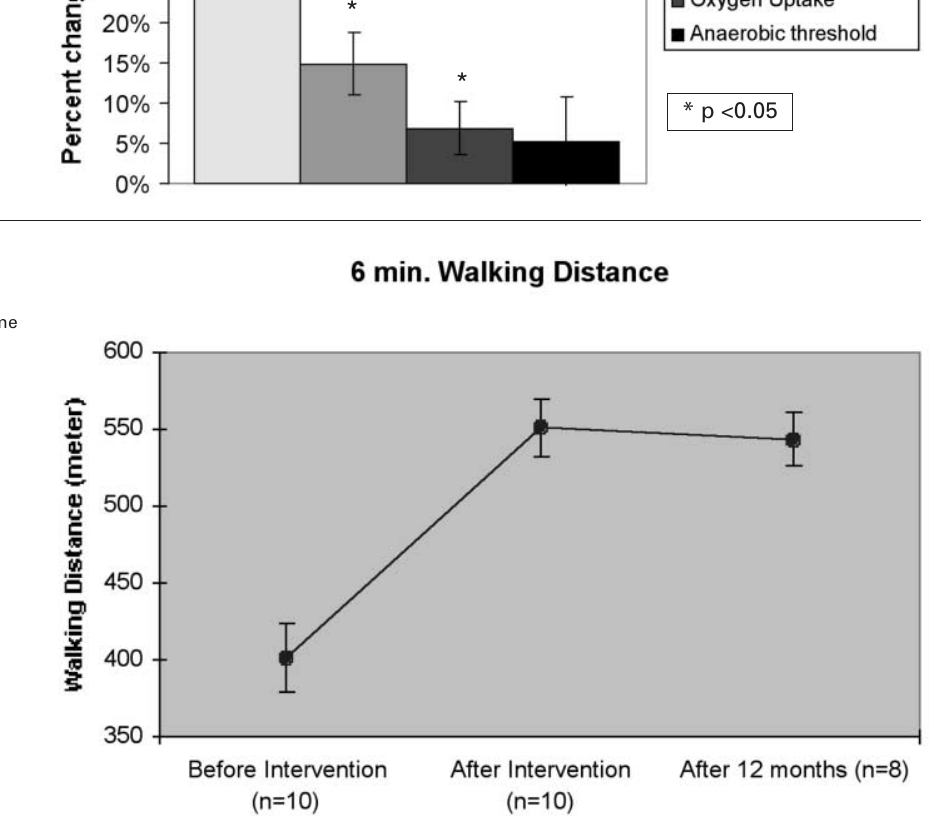
high intensity training at the anaerobic threshold (1.07 ± 0.4 vs. 1.07 ± 0.3, p = 0.80). However, the pulse rate at the anaerobic threshold decreased sig- nificantly (124 ± 3 vs 118 ± 2, p = 0.0019). The im- provement in walking distance remained signifi- cant at 12 months follow-up (fig. 3).